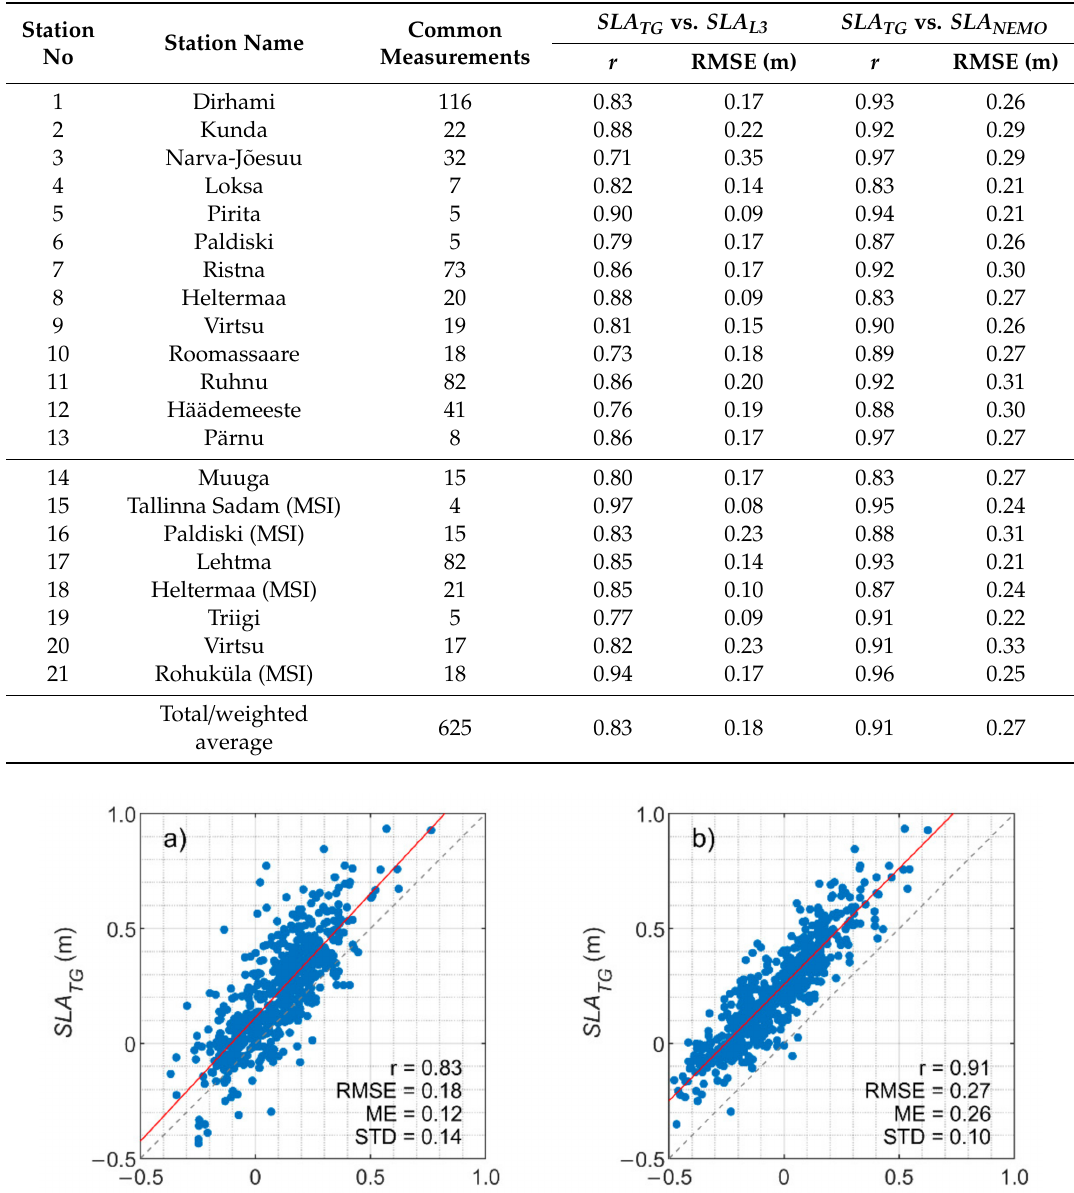
Table 6. Overview of tide gauges (Figure 2) used for comparison with CMEMS products in the Baltic Sea. Comparison results ( r and RMSE) between SLA TG , SLA L3 and SLA NEMO are shown in the last four columns.